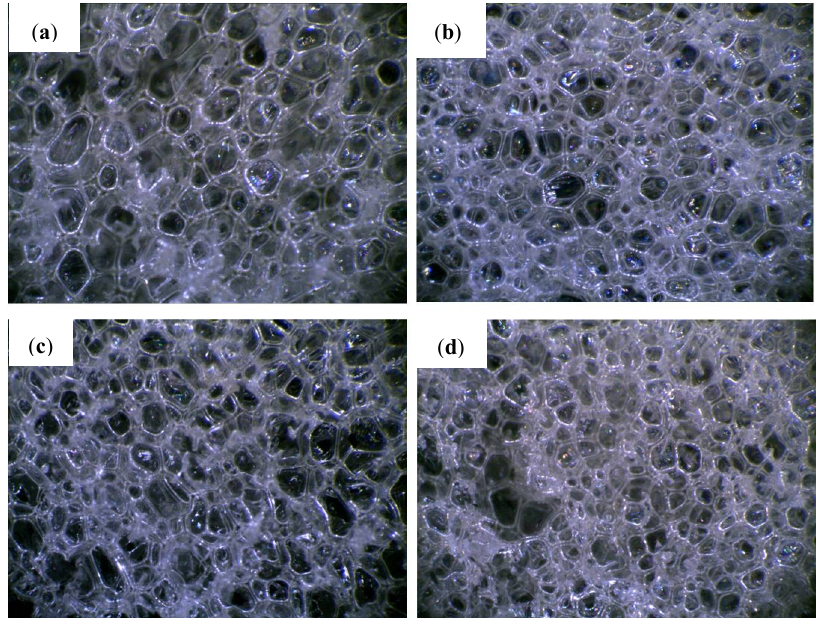
Figure 1. Cellular morphology of ( a ) PUR-0, ( b ) PUR-POSS-Ar-Cl, ( c ) PUR-POSS-Pr-Cl and ( d ) PUR-POSS-Ar-Et-Cl.